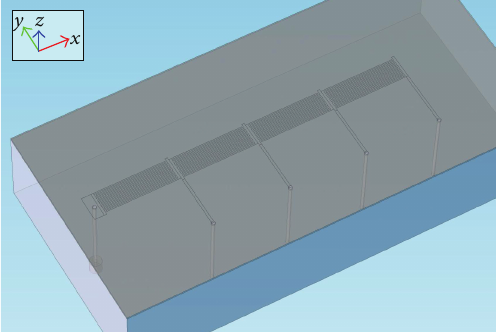
be treated. SAR distribution in the area to be treated is also displayed here.